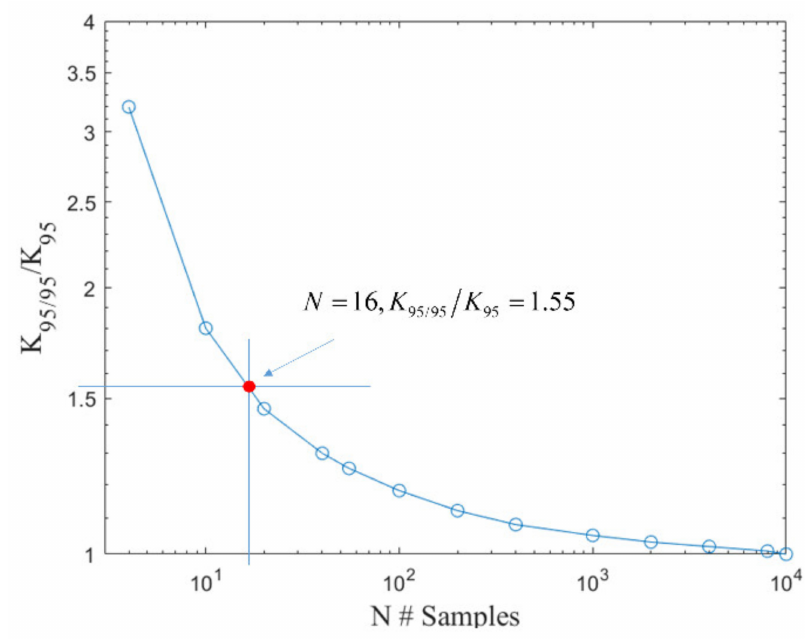
Figure 9. K -Coverage determination with unknown mean and standard